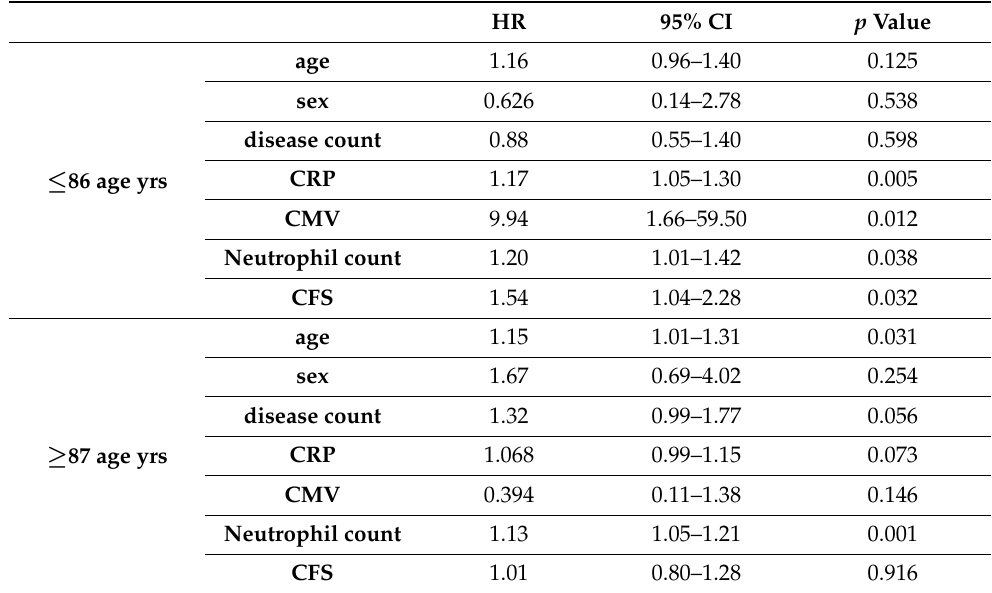
Table 3. Multivariable cox regression analysis of associated factors with in-hospital mortality in COVID-19 patients stratified by